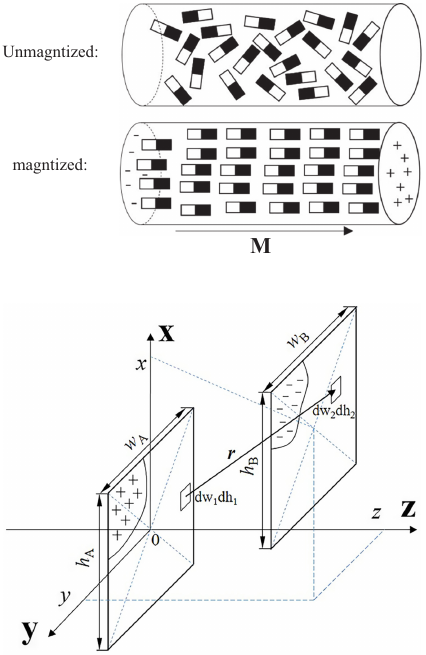
Figure 9. Coordinate system of the interaction between two unlike magnetic pole faces where magnetic charges